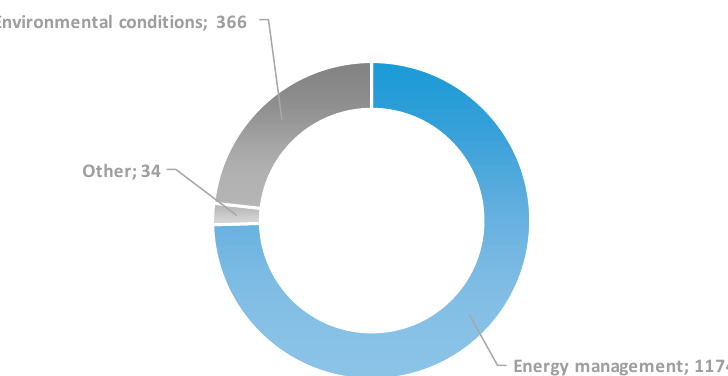
Figure 8. Distribution of active sensors per application sub-domain within the Smart Building domain.